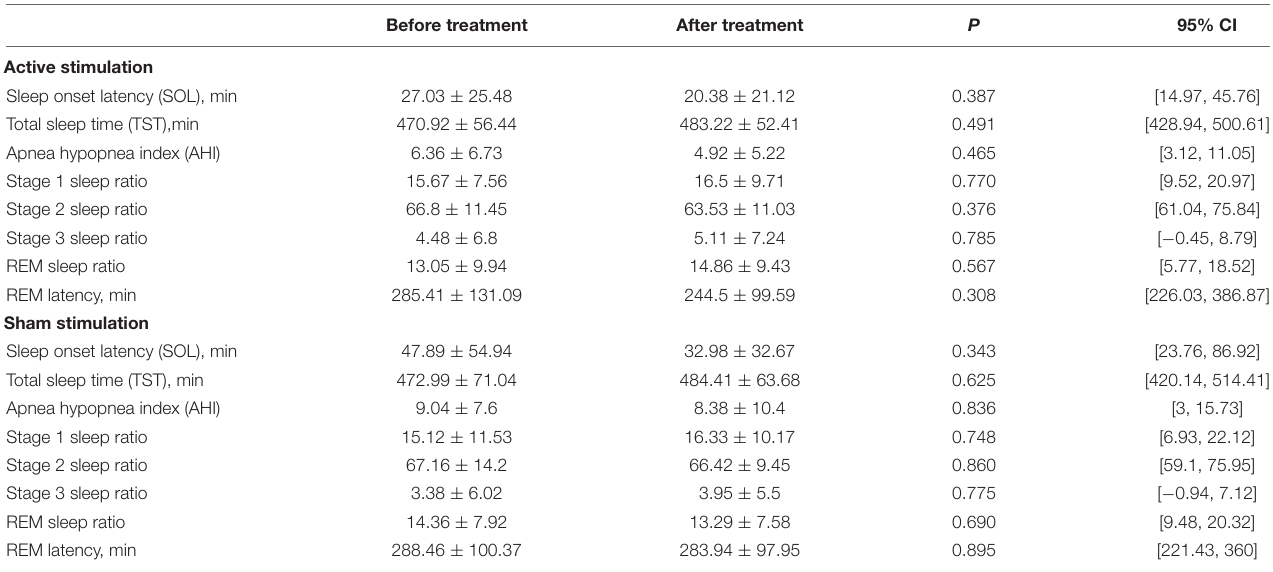
TABLE 2 | Polysomnography (PSG) sleep structure before and after treatment in tDCS and sham group. Before treatment After treatment P 95%